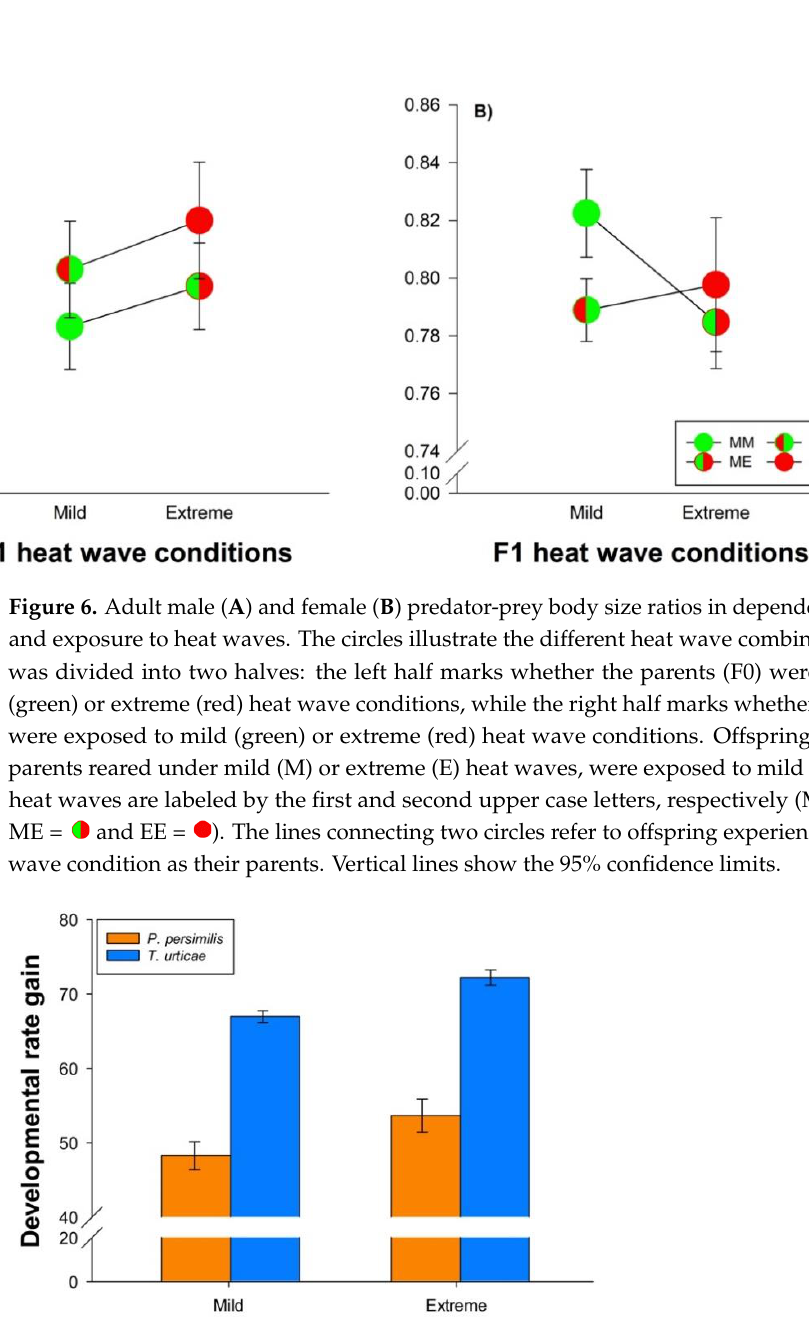
Figure 5. Heat wave effects during juvenile development on the leaf damage, age at maturity, and size at maturity of males ( A , C , E ) and females ( B , D , F ) of the prey T. urticae . The circles illustrate the